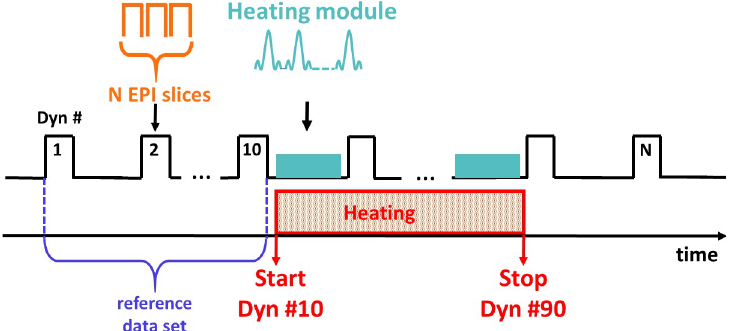
Fig 1. Schematic of the MRI-thermometry technique. Single shot gradient echo EPI acquisition interleaved with a train of RF pulses (heating module) with adjustable flip angle, inter-pulse delay and number of